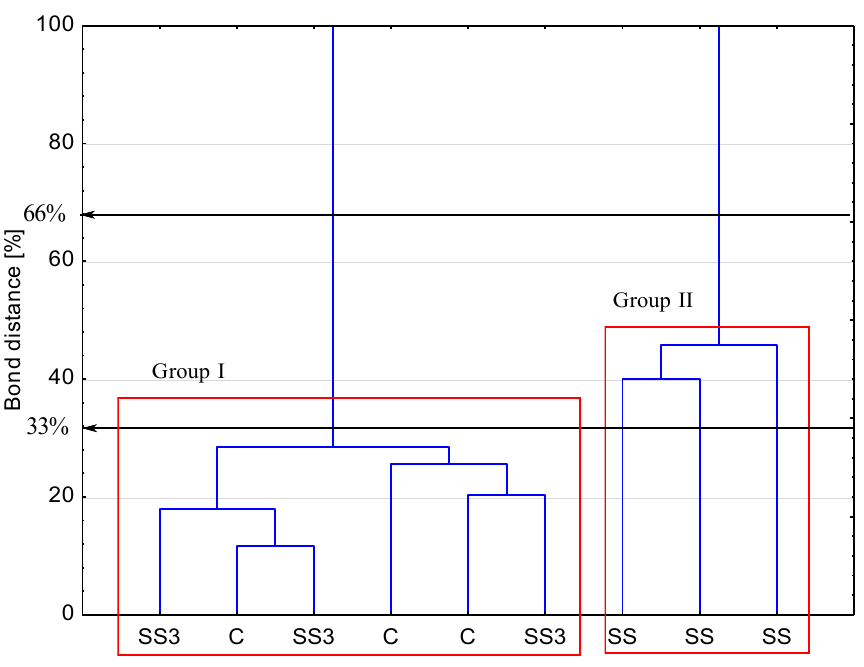
Figure 4. Dendrogram of the bond distances between the carbon utilizations patterns of the substrates located on the Biolog EcoPlates TM . Grouping was conducted according to the stringent Sneath criterion (33%) and the less restrictive criterion (66%), respectively. SS—soil under sewage sludge accumulation, SS3—soil 3 meters from the sewage sludge landfill, C—control soil 200 meters from sewage sludge landfill, n =